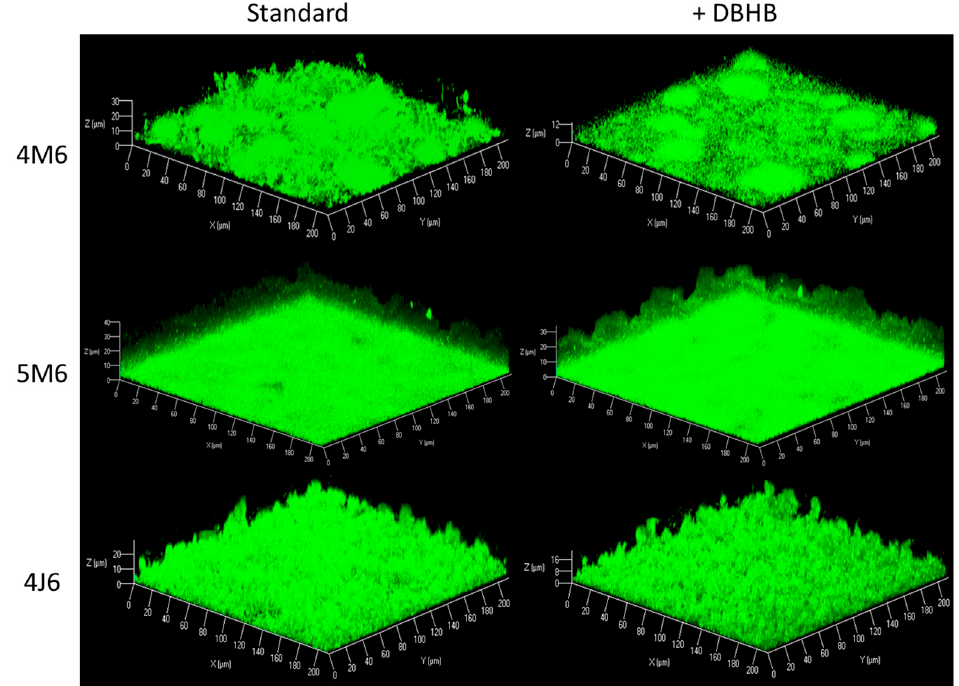
Figure 2. Impact of DBHB on the bacterial biofilm formation. CLSM observations of the bacterial biofilm grown on glass surface at 20 °C under a flow of medium without addition of DBHB (Standard) and containing DBHB at 16 µ M (+DBHB). Biofilms of Paracoccus sp. (4M6), Pseudoalteromonas sp. (5M6) and Bacillus sp. (4J6) were detected by staining the cells with Syto 9. Table 1. Percentage of inhibition of bacterial biofilms in the presence of DBHB (16 μ M).